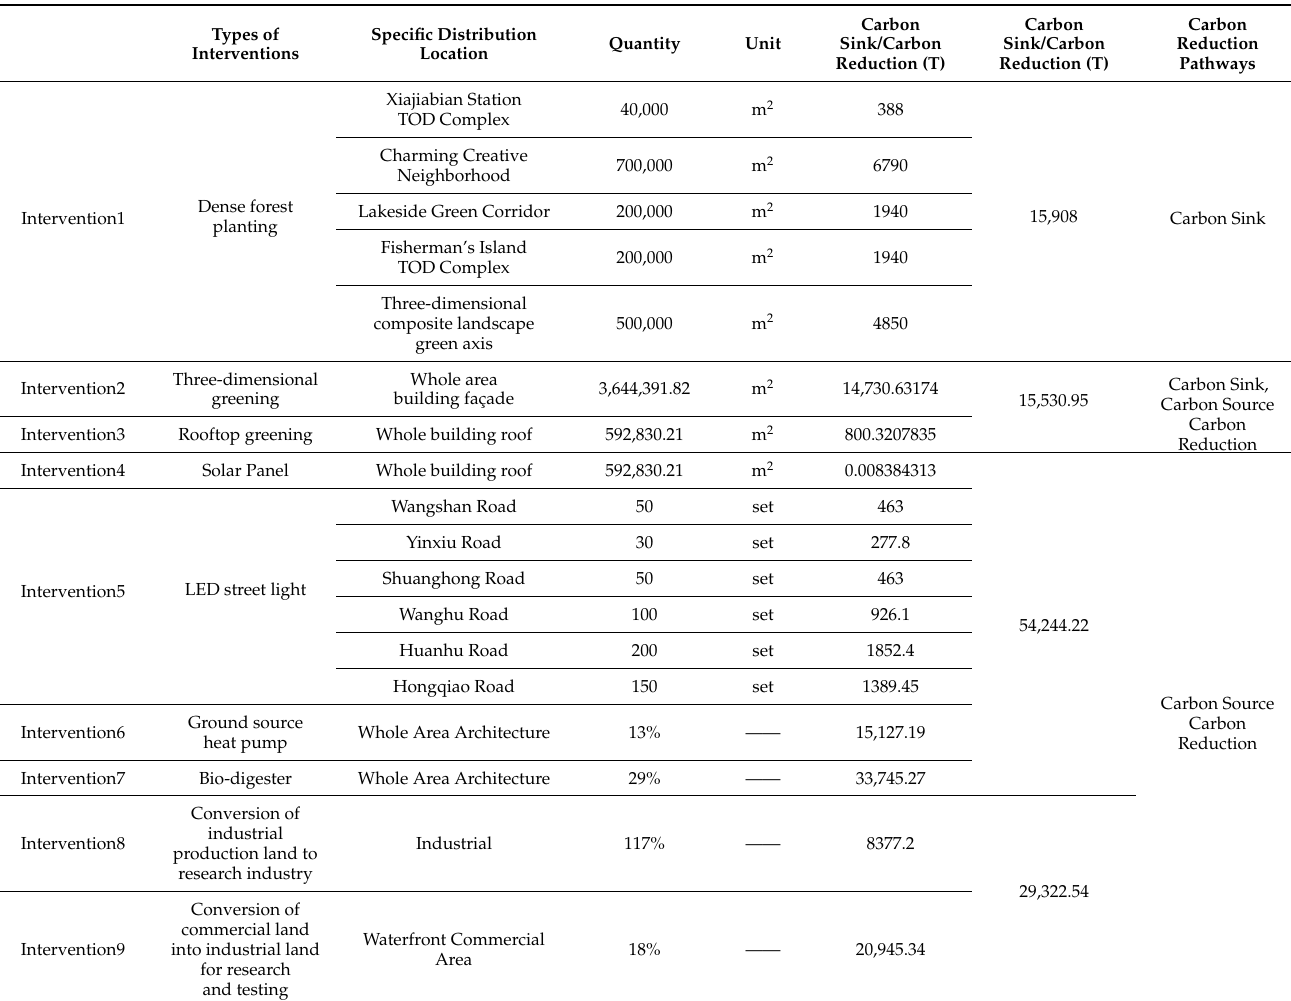
Table 8. Specific information on carbon source reduction or carbon sink